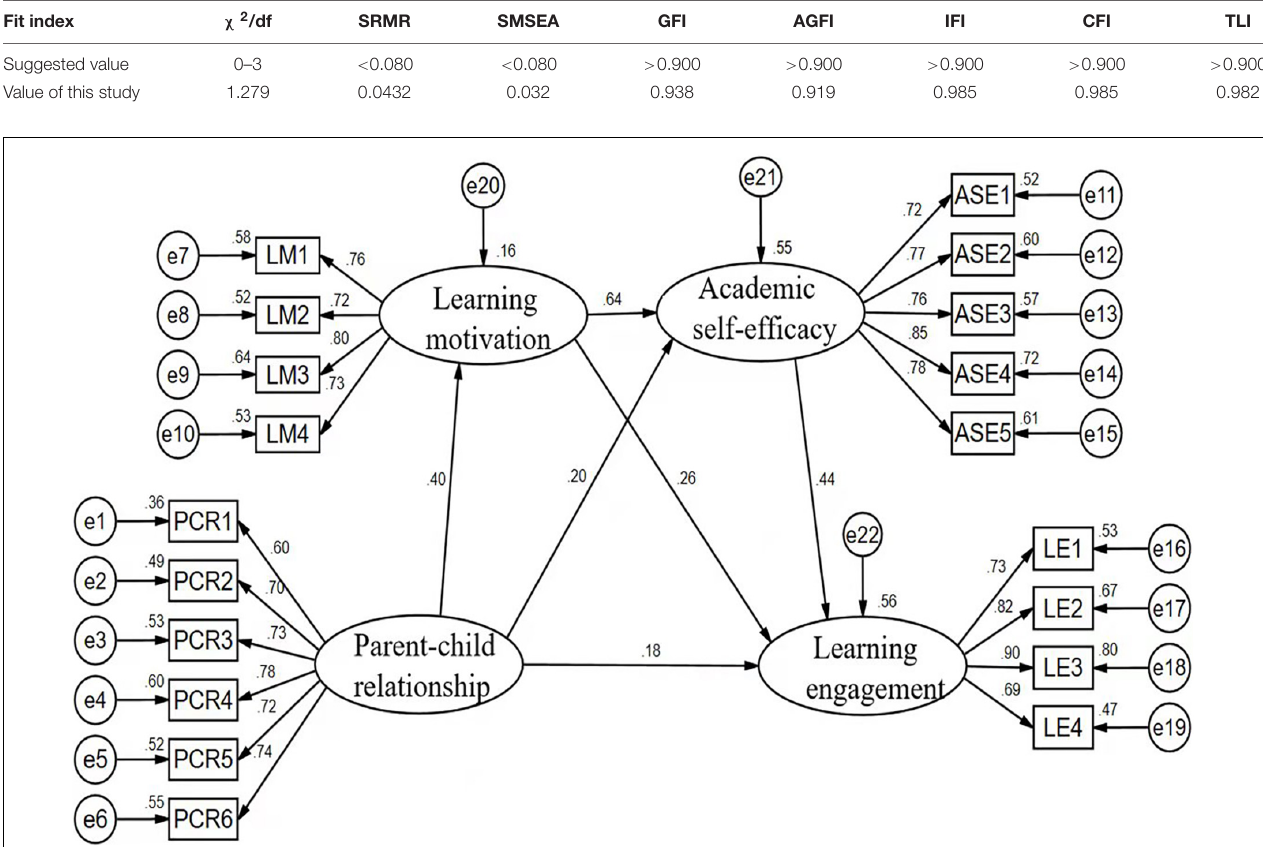
TABLE 4 | Goodness of fit index of the structural model.